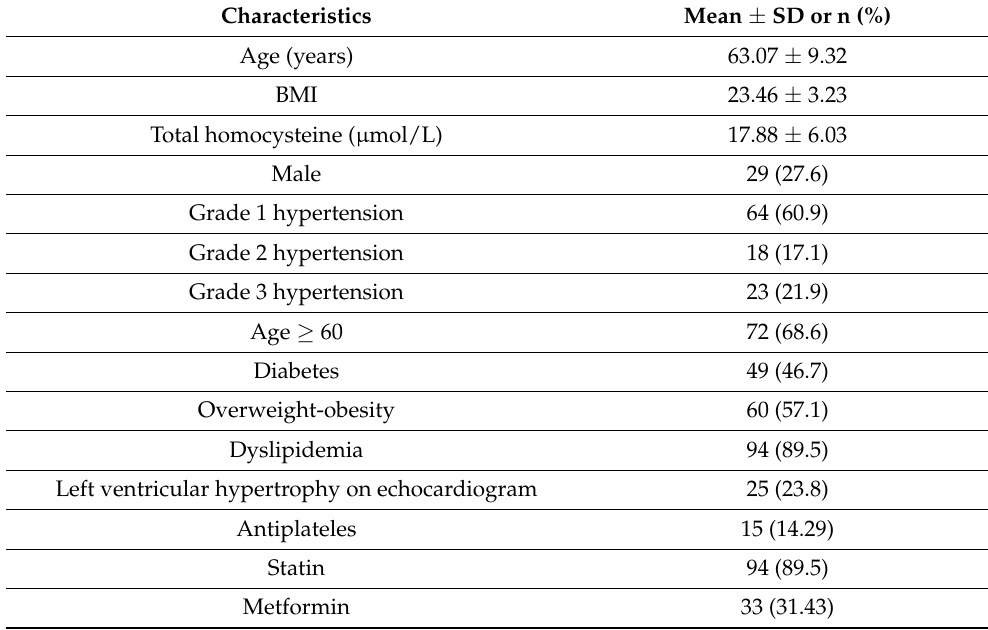
Table 1. Baseline characteristics of the study